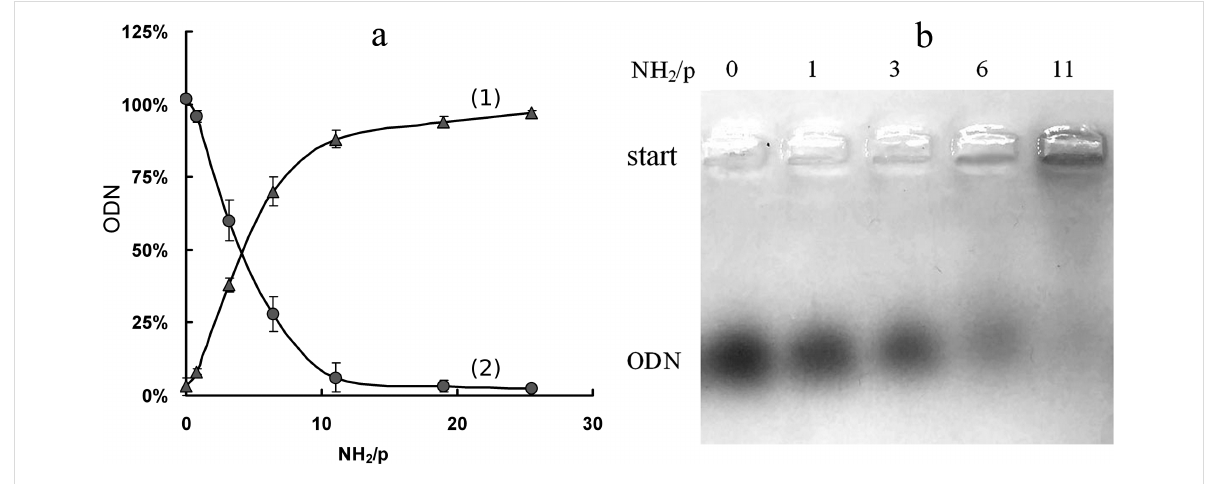
Figure 1: (a) Evaluation of molar ratio of the amino groups in the nanoparticles to the phosphate groups, NH 2 /p, for the complete binding of ODN(1) with Si–NH 2 nanoparticles using the “acetone precipitation” technique. The amount of (1) bound and (2) unbound ODN(1) is shown. (b) Electrophore- sis in agarose gel.